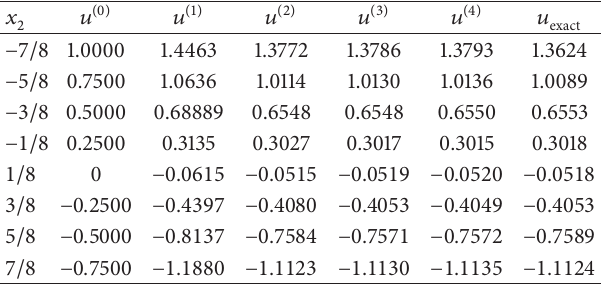
Table 1: Iteration results 𝑢 (𝑖) for Example 1 when 𝑚 = 8 and 𝑥 1 = −1/8 .